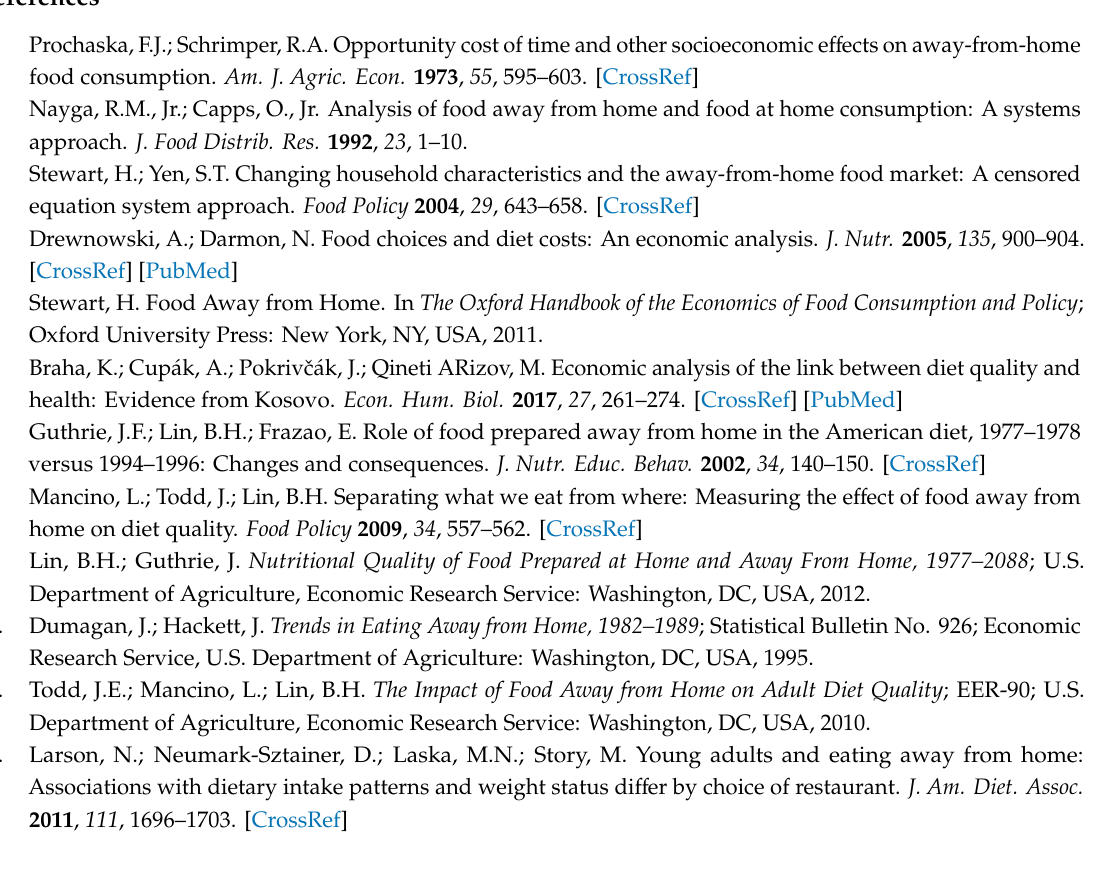
Table S1: Korean Dietary Reference Intakes, Table S2: Covariate balance summary for treated group 1. Table S3: Table S5: Mean estimation of outcome variable over